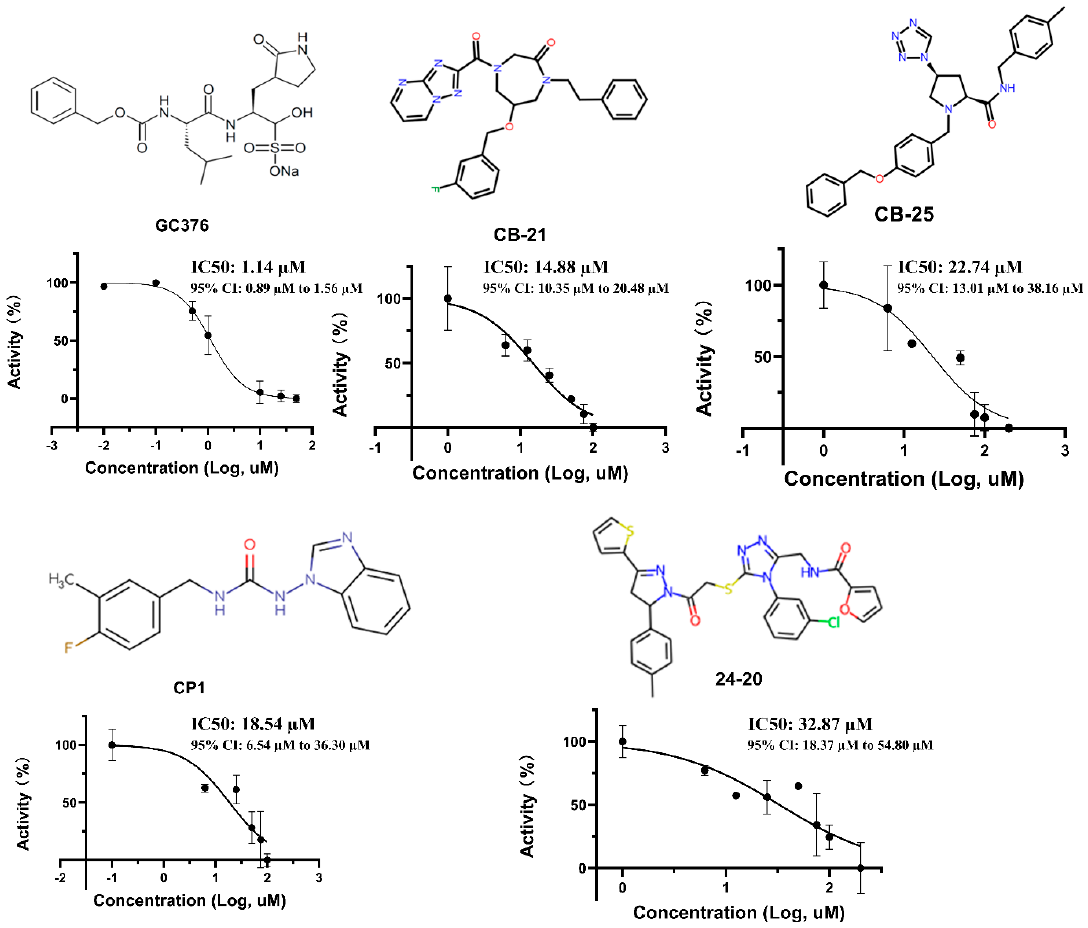
Figure 1. Structure and IC50 test of each compound. 95% CI: 95% Confidence